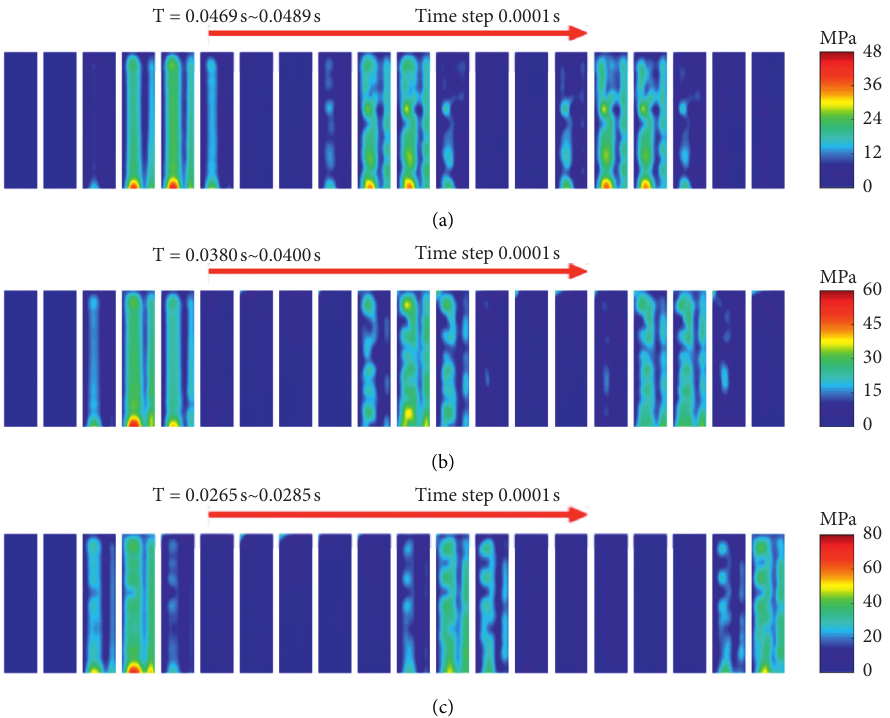
Figure 12: Phase I: Real-time stress distribution of the contact area on axle spline surface under different loading cases. (a) Real-time stress status under 0.3 m/s2 driving rate, #10 tooth. (b) Real-time stress status under 0.5 m/s2 driving rate, #10 tooth. (c) Real-time stress status under 1 m/s2 driving rate, #10 tooth.